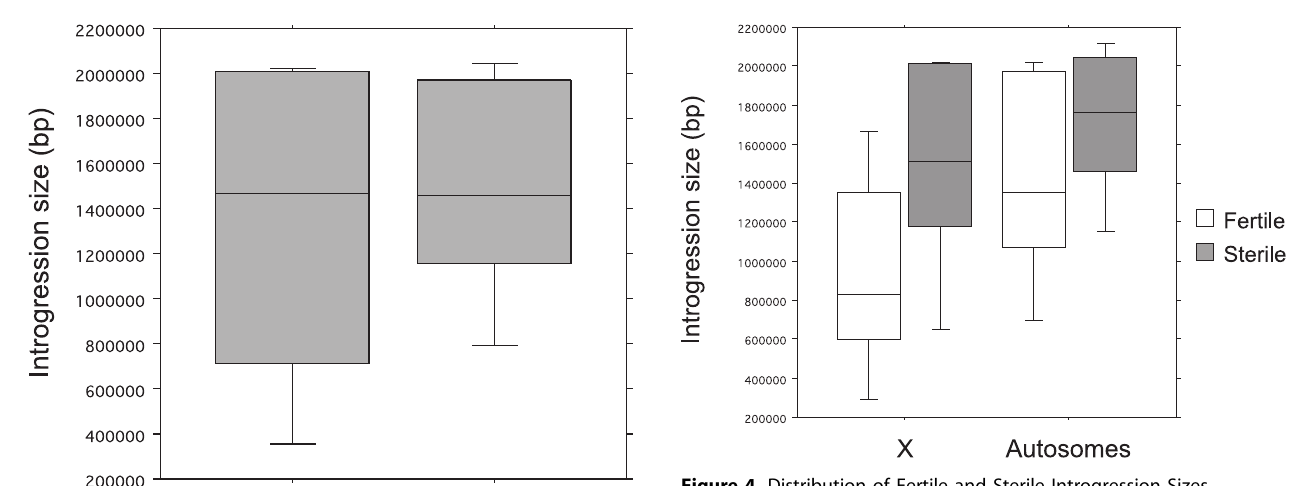
Figure 4. Distribution of Fertile and Sterile Introgression Sizes Boxes show the interquartile range; vertical lines are drawn out to the extreme values; horizontal lines within boxes show the median.